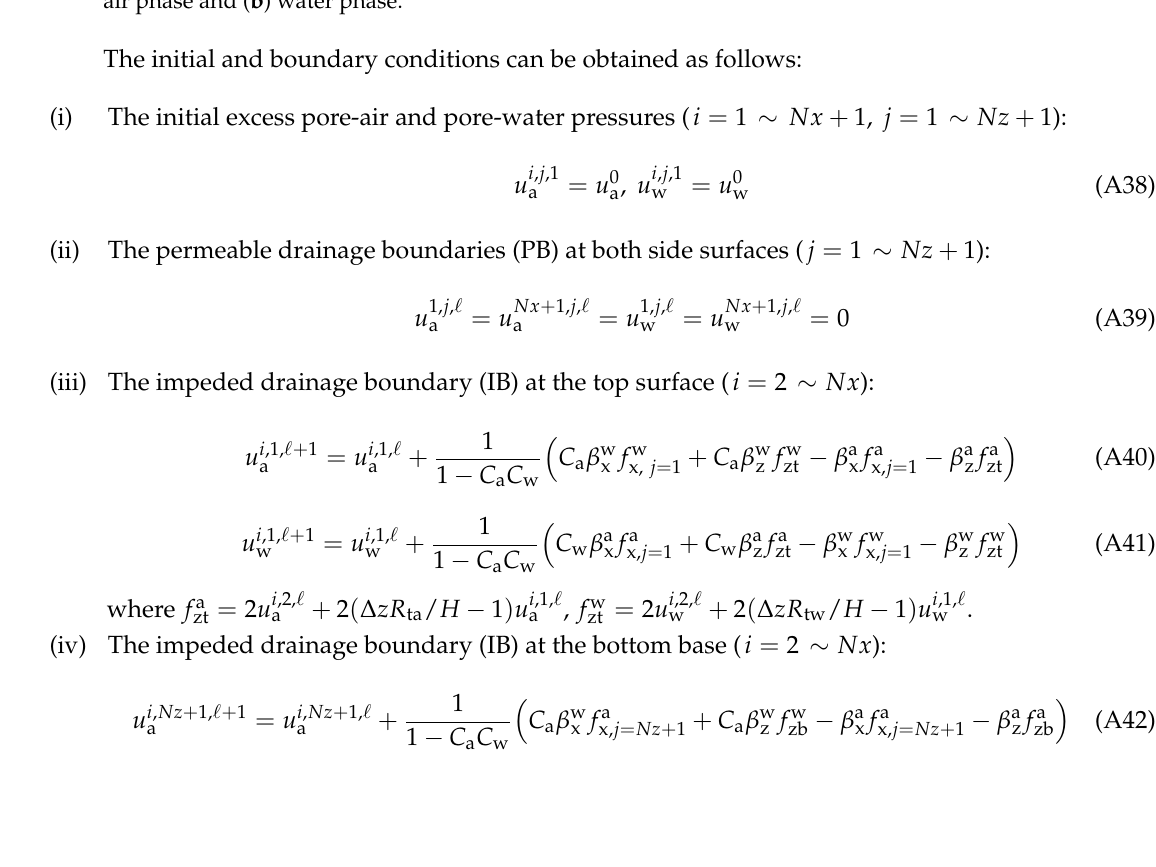
Figure A1. Forward time and central space (FTCS) difference scheme for the governing equations: ( a ) air phase and ( b ) water phase.